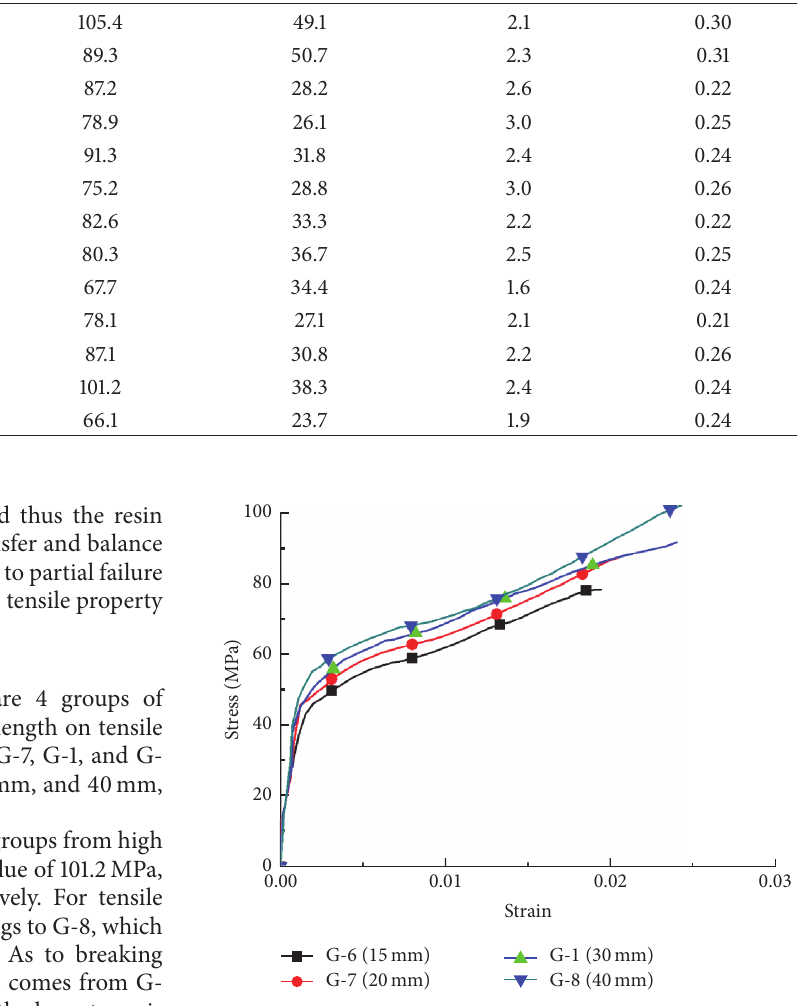
Figure 14: Comparison of stress-strain curves of sprayed FRP with different fiber